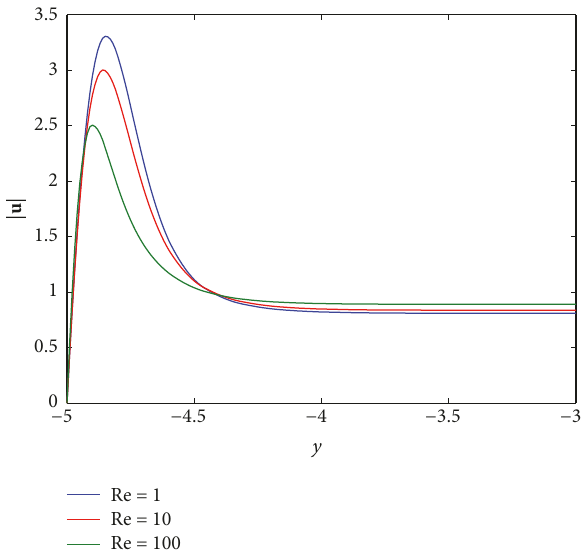
Figure 3: Flow profiles in fixed bed reactor at 𝑥 = 50